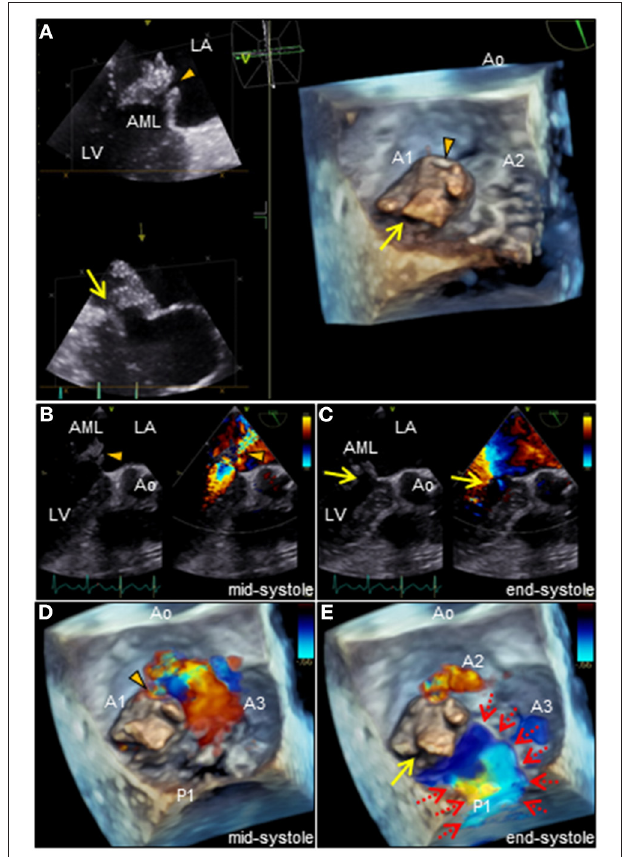
FIGURE 2 | (A) Three-dimensional TEE of the mitral valve. Note the two distinct ruptured perforations through the MVA (arrowhead and arrow, respectively). (B–E) Two or three-dimensional color Doppler TEE reveals that severe MR with two different jets communicate with the LA through the MVA: a superior jet (arrowhead) and a posterior jet (arrow), respectively. Note the MR with posterior jet heading toward the LA via the PML surface (dotted arrows). AML, anterior mitral leaflet; Ao, aorta; LA, left atrium; LV, left ventricle; MR, mitral regurgitation; PML, posterior mitral leaflet; MVA, mitral valve aneurysm, TEE, transesophageal